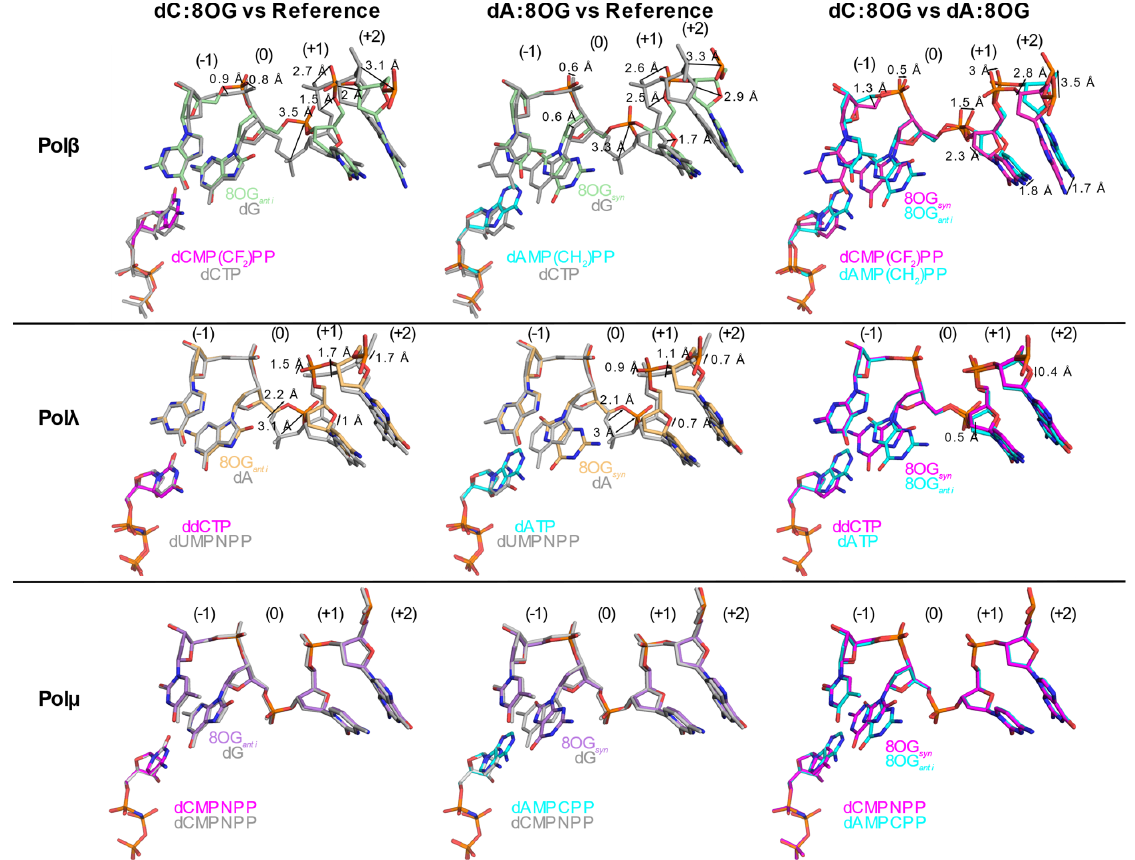
Figure 3. A gradient of backbone distortions observed in 1nt-gapped DNA substrates due to the presence of an oxidized guanine. Structures of pre-catalytic ternary complex structures with single-nucleotide gapped DNA containing a template 8OG are drawn in stick representation for Polβ (top row), Polλ (middle row), and Polµ (bottom row) with either cytidine (magenta, PDB ID codes 3RJI [54], 5IIJ [34], or 6P1P [35]) or adenine (cyan, PDB ID codes 3RJF [54], 5III [34], and 6P1N [35]) nucleotides. These structures (incoming dC:8OG, left column and incoming dA:8OG, middle column) were superimposed with a correctly paired reference structure (gray, PDB ID codes 4KLD [32], 2PFO [63], and 6P1V [35]). Superpositions of the incoming dC:8OG (magenta) and incoming dA:8OG (cyan) structures are shown in the right column. The naming convention is that of the incoming nucleotide:template nucleotide. The templating position is designated 0 and the downstream and upstream positions are labeled with positive and negative integers, respectively.